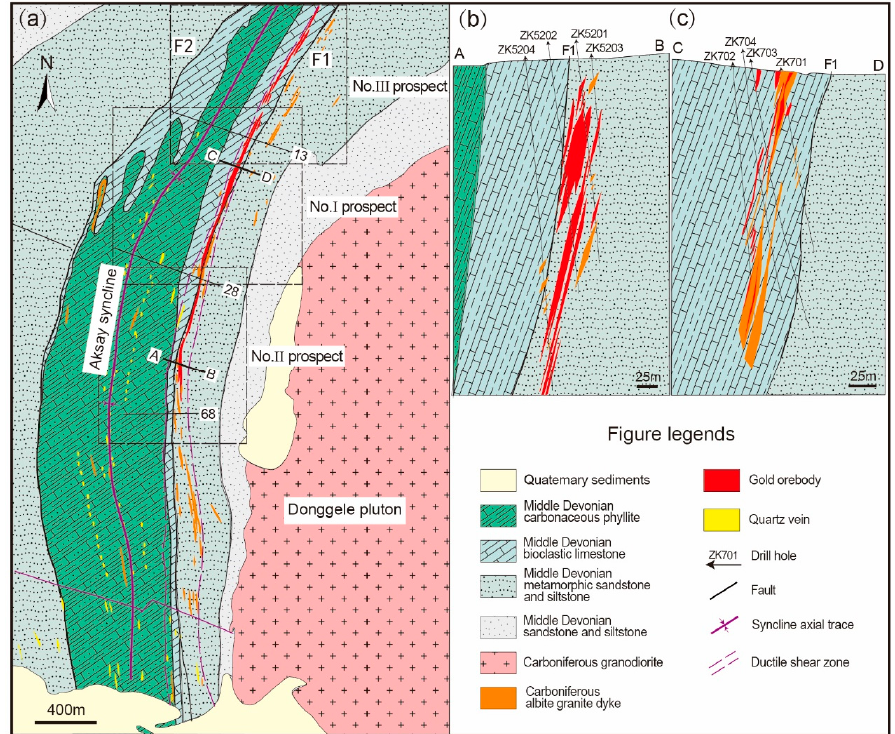
Figure 2. Simplified geological map of the Doranasai gold deposit (reprinted with permission from Ref. [1]). ( a ) Map showing the spatial relationship of orebodies with syncline, shear zone and granitic rocks; ( b ) profile showing orebody occurrence in Prospect II; ( c ) profile showing orebody occurrence in Prospect I.